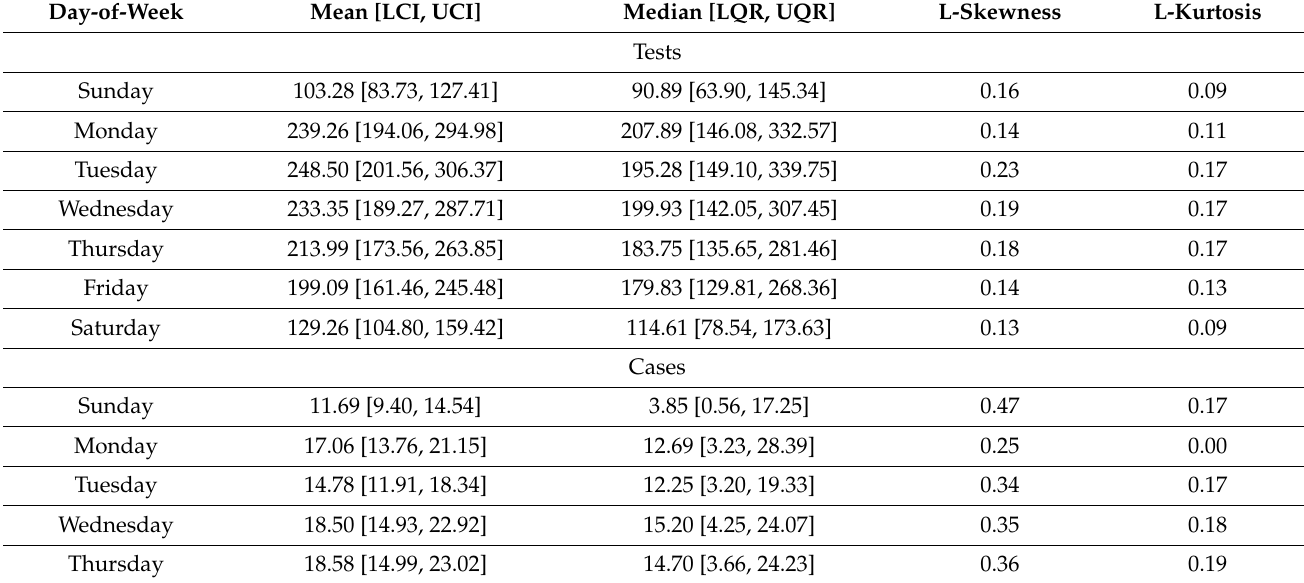
Table 4. Descriptive summaries of rates for reported tests, cases, and deaths by DoW from 2 March 2020 through 7 November 2021. We extracted data on state-level tests from the Massachusetts Department of Public Health COVID-19 data dashboard and data on county-level cases and deaths from John Hopkin’s University’s COVID-19 data dashboard. We estimated average rates (with 95% confidence intervals) using negative binomial regression models adjusted for log-link functions. We also report median rates (with interquartile range), L-skewness values, and L-kurtosis values by DoW and health